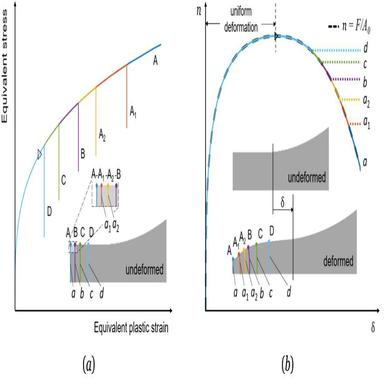
(a) Equivalent stress vs. equivalent plastic strain for different points on the external surface of the specimen. (b) Engineering (or nominal) stress vs. half elongation of the gauge length; each curve (except for the dashed one) is obtained by applying Eq. to the corresponding section. The points and the sections considered are shown in the undeformed configuration on the left plot and in a deformed configuration on the right plot. The triangle represents the necking onset.